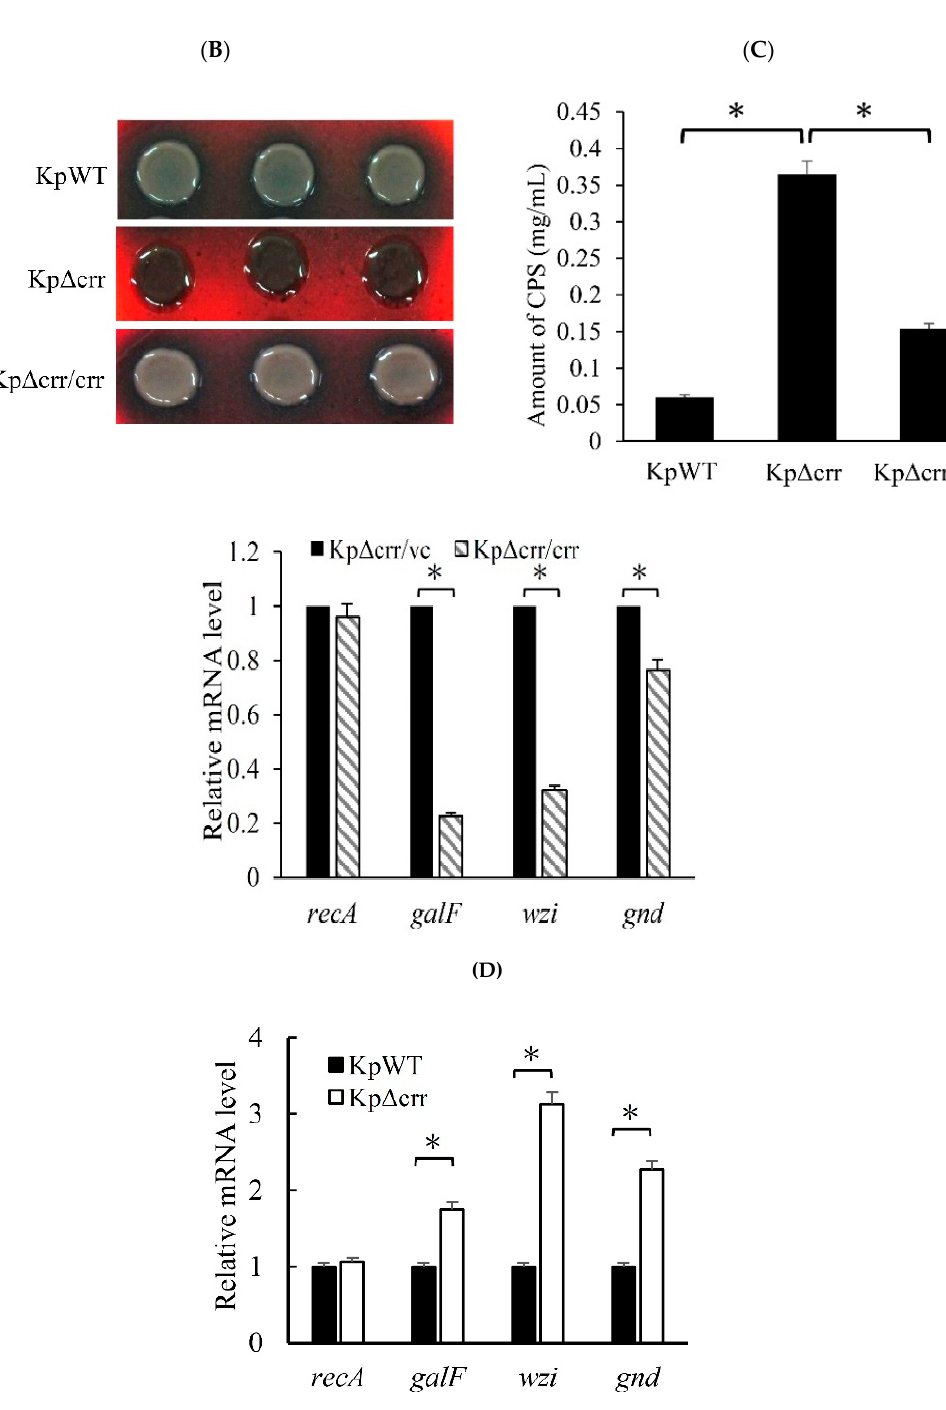
Figure 3. Deficiency of crr enhanced CPS production in K. pneumoniae . ( A ) Light microscope images of bacteria after India ink staining. Capsular saccharide was visualized by a cleared zone (ink exclusion) around the bacteria. ( i ) Images were obtained at 400 × magnification. ( ii ) Enlargement of the rectangle outlined with a white dashed line in ( i ). ( iii ) Enlargement of the rectangle outlined with a white dashed line in ( ii ). ( iv ) The width of the capsule was analyzed by measuring the red dashed line in ( iii ). The scale bar, white horizontal line, in subfigure ( iii ) = 1 µ m. ( B ) Representative images of bacteria on Congo red agar (CRA) plates. ( C ) Quantification of bacterial CPS. ( D , E ) Transcriptional analysis of the housekeeping gene recA and cps locus genes, including galF , wzi and gnd , by dye-based RT-qPCR. The relative mRNA levels indicate that the mRNA amount in Kp ∆ crr was normalized to that in KpWT in ( D ) or that the mRNA amount in Kp ∆ crr/crr was